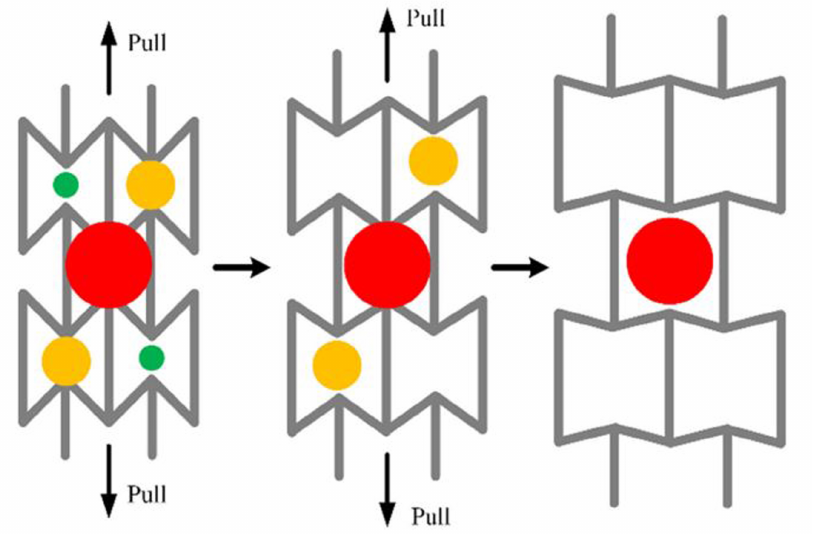
Figure 9. Schematic of variable permeability in auxetic structures. Reprinted with permission from Ref. [110]. Copyright 2020,